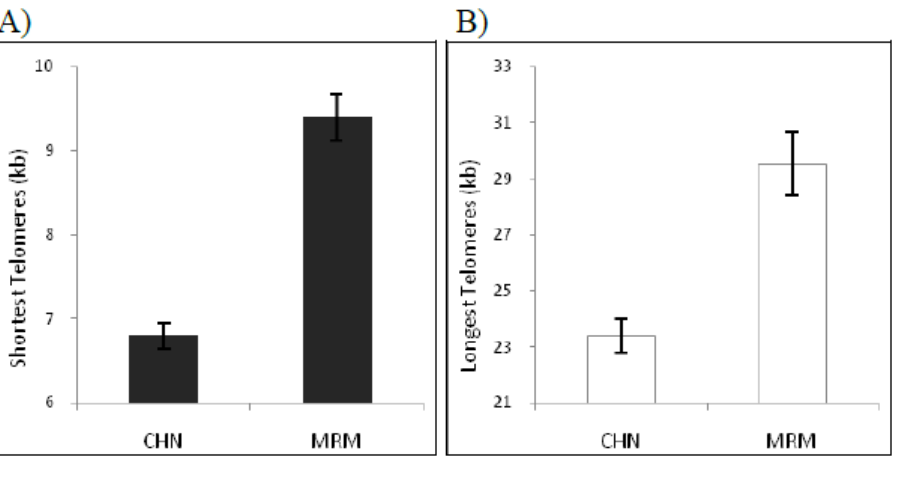
Figure 5. Distribution of telomere length by Chianina (CHN) and Maremmana (MRM) breeds. Measured (kb) includes the shortest telomere length A) and the longest telomere length B)